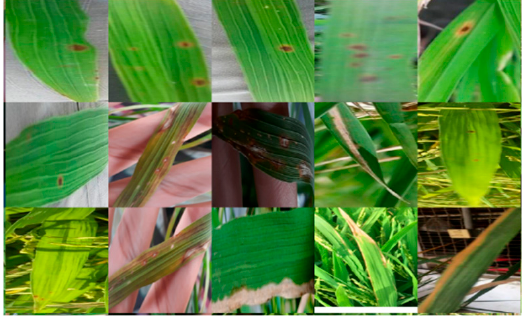
Figure 11. Real images.